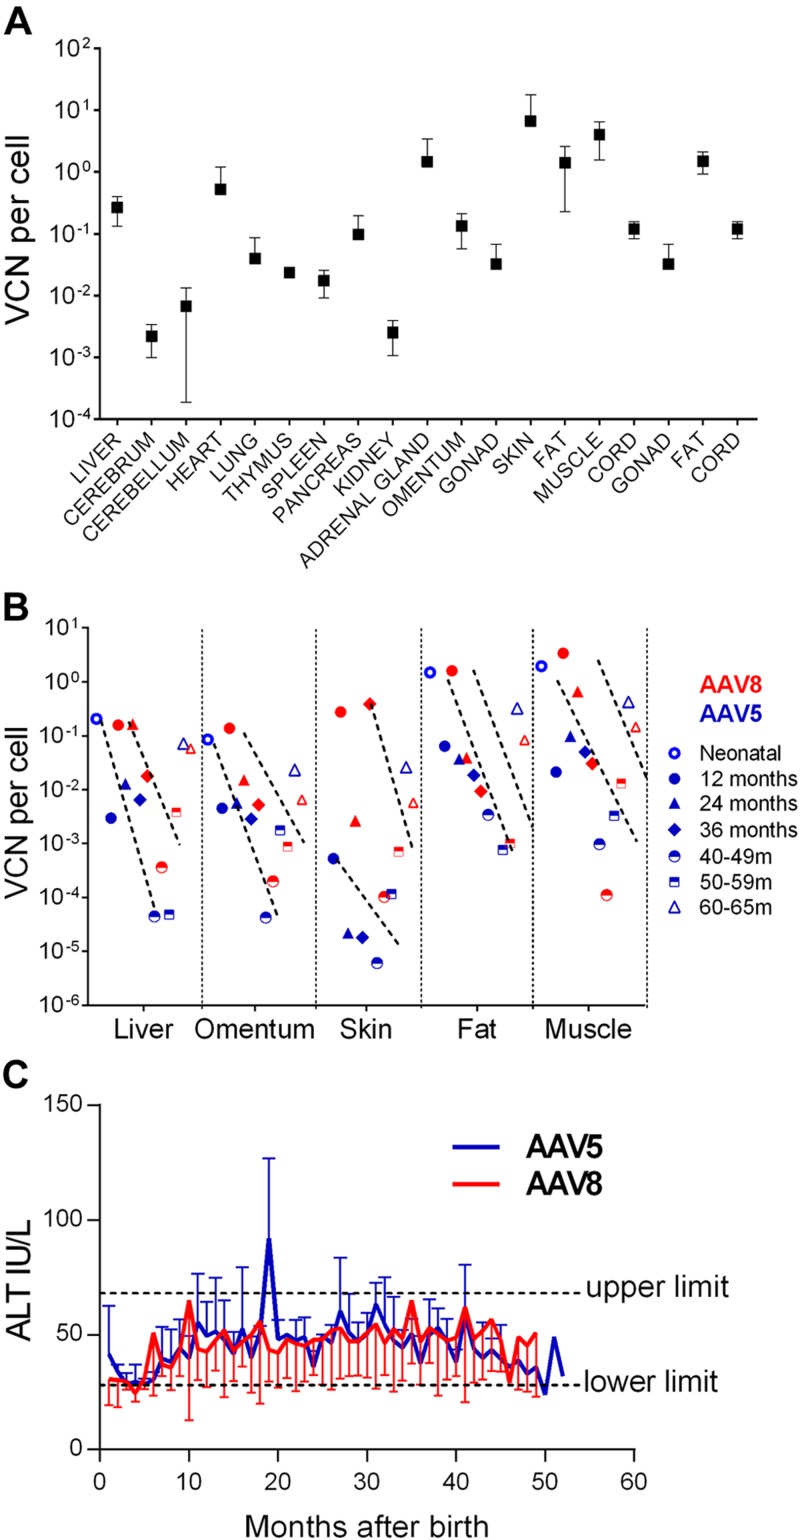
Vector biodistribution and hepatotoxicity. A) VCNs showed wide variation with most subjects expressing 1 vector copy every 10–1000 cells in the absence of specific organ tropism. B) Regardless of initial VCN, all tissues showed a substantial decline in tissue vector load of 1–3-log-fold every 12 mo; there was no difference between AAV5- and AAV8-treated animals. C) Liver-specific ALT levels increased intermittently, particularly in AAV8 recipients, but overall transaminases remained in the normal range.